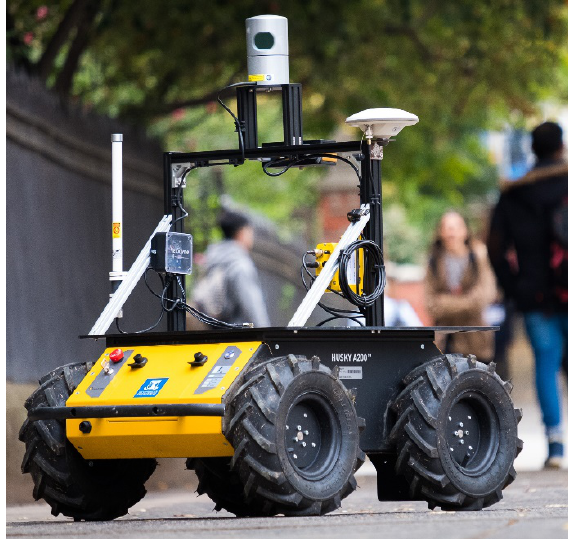
Figure 4. The Husky vehicle and Velodyne lidar